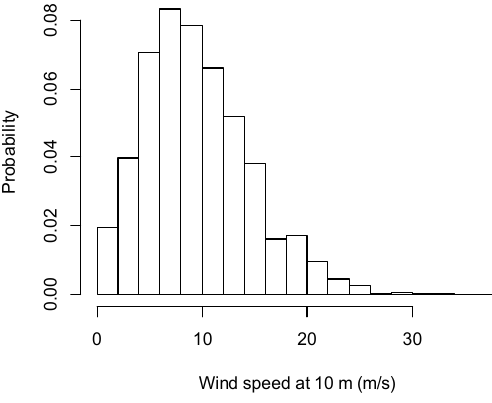
Figure 4. Histogram of the wind speed at 10 m.